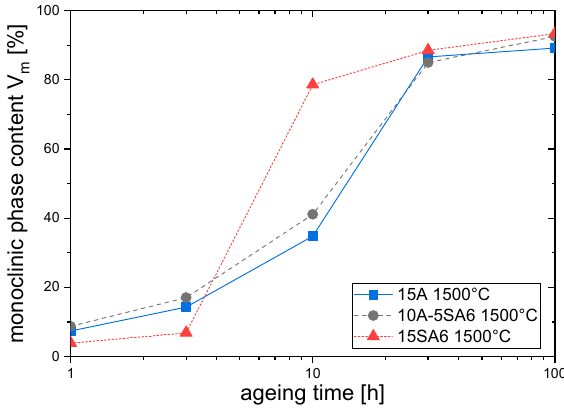
Figure 6. Low temperature degradation of selected materials.